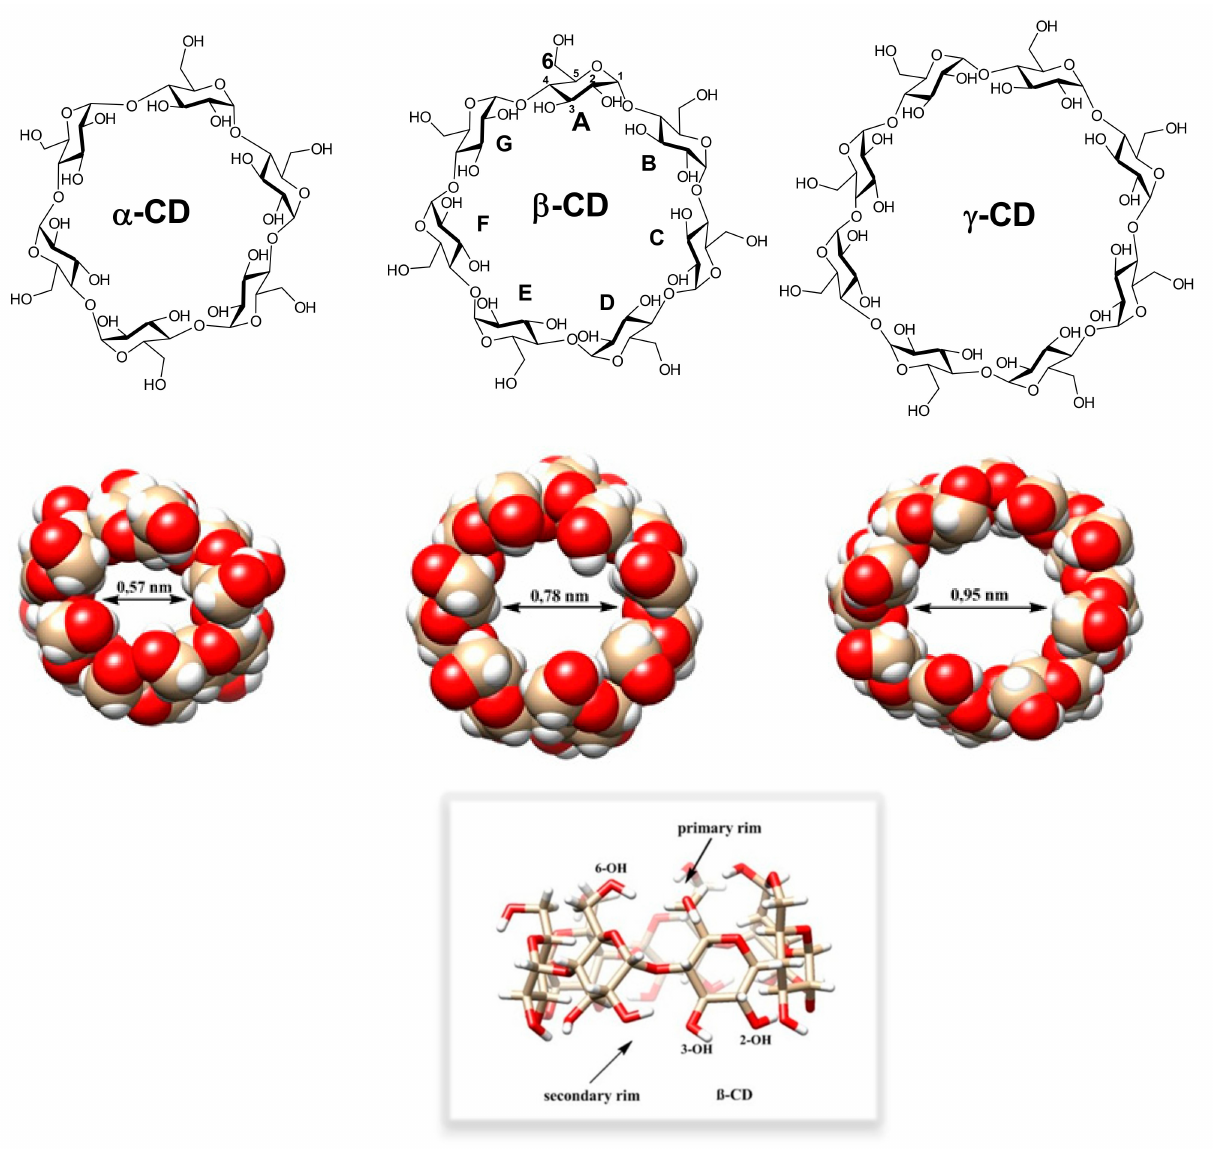
Figure 1. Structure, the numbering of glucose units (A, B, etc.) and atoms (1, 2, etc.), and 3D models of native